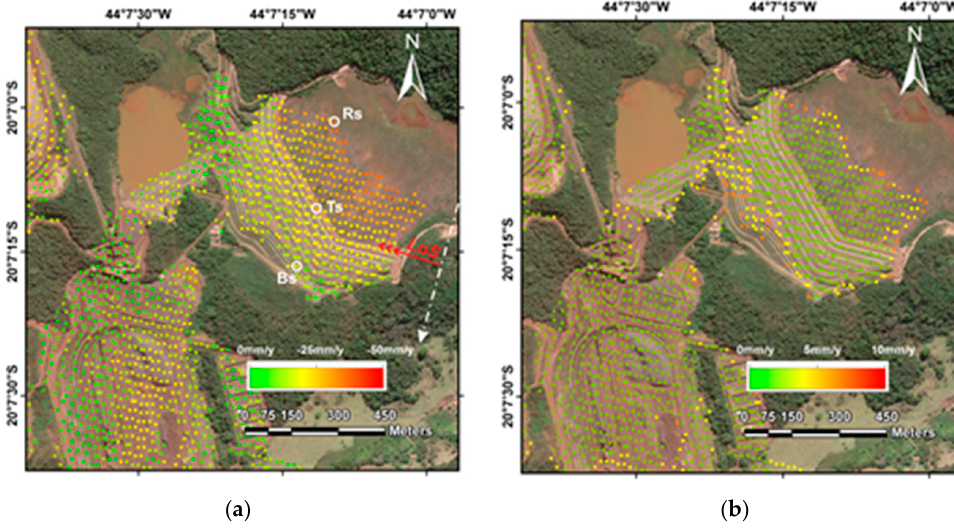
Figure 5. Map of the displacement rate ( a ) and the standard deviation ( b ) from the SBAS analysis; white circles represent the analyzed points in the dam reservoir ( Rs ), crest ( Ts ) and bottom face ( Bs ).